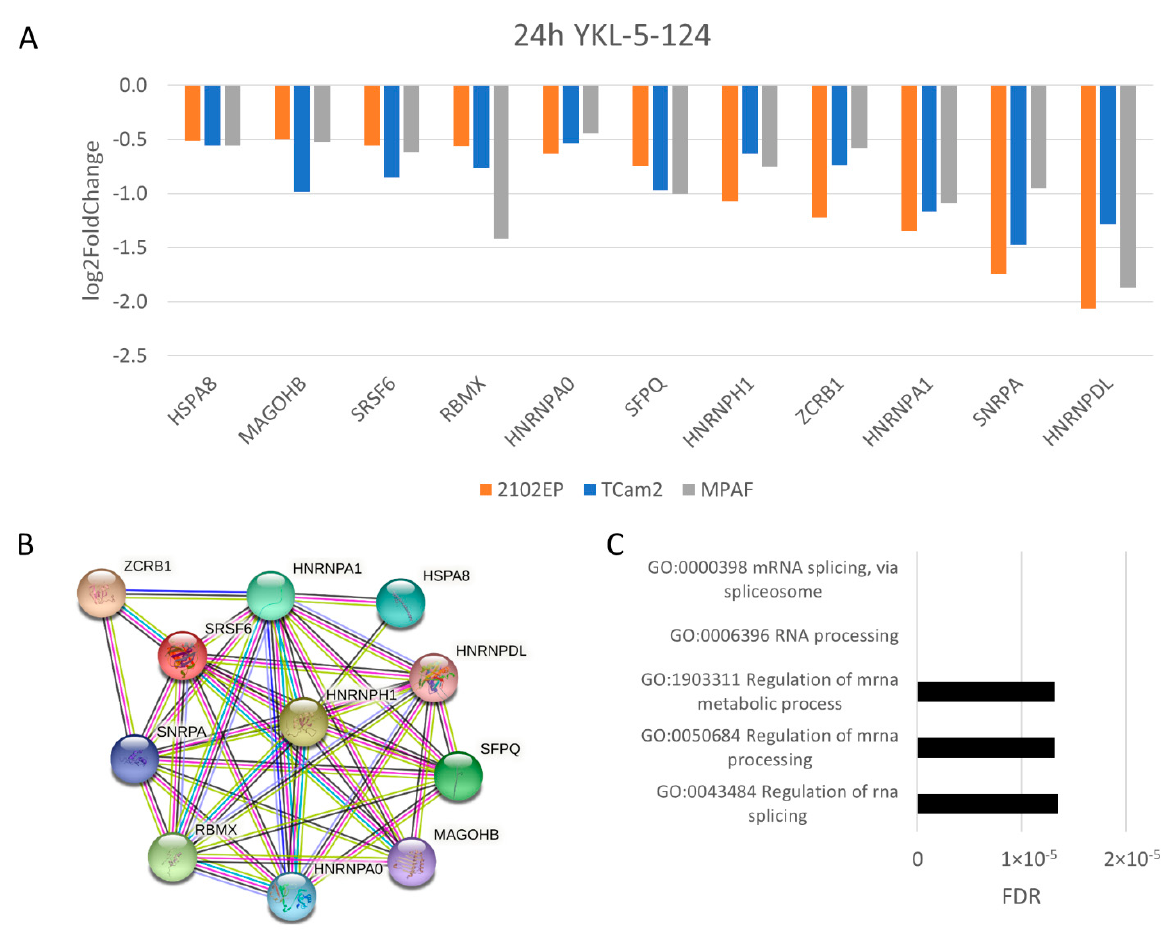
Figure 5. Elucidating molecular effects of YKL-5-124 treatment. ( A ) Commonly downregulated genes after 24 h of treatment (100 nM). ( B ) STRING-based interaction analysis and ( C ) Gene Ontology analysis of commonly downregulated genes. For all samples, n = 3.